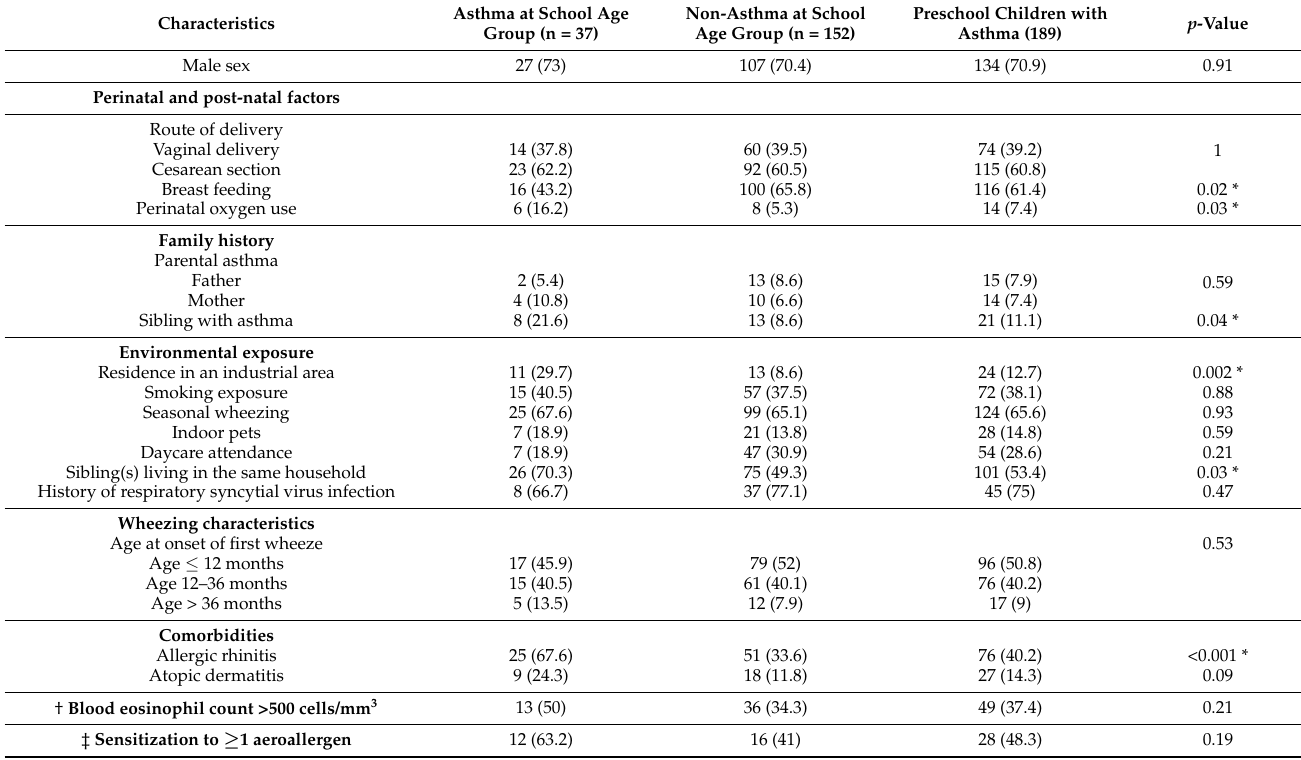
Table 1. Factors associated with persistent asthma at school age (n =